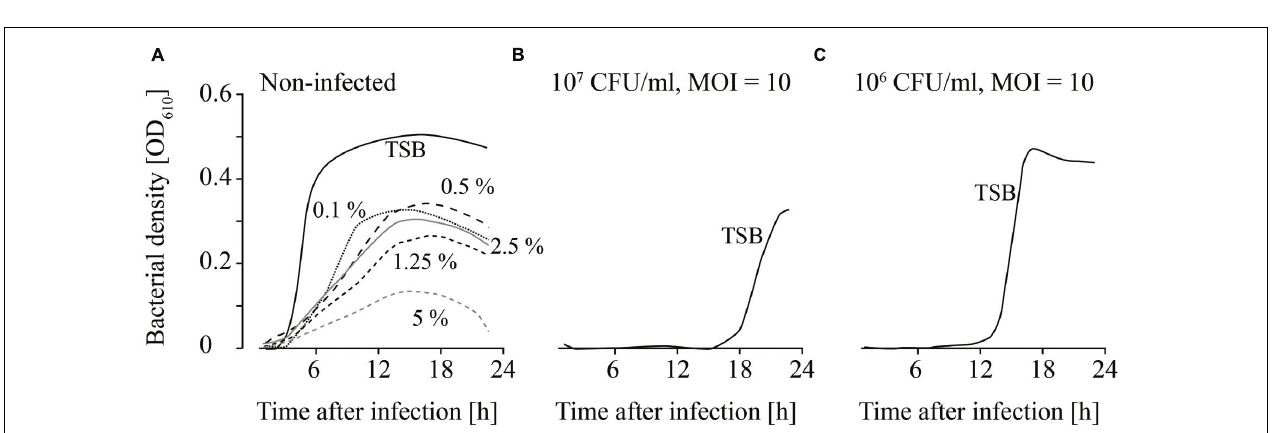
FIGURE 5 | Growth of uninfected (A) and infected (B,C; MOI = 10) L. monocytogenes in TSB adjusted to different pH values. The bacteria concentrations at the beginning of the infections were 10 7 CFU/ml (A) and (B) and 10 6 CFU/ml (C) . All pH values (4–11) were tested. For the sake of clarity only the curves of growing bacteria were demonstrated while the others on base line level were not depicted. Moreover, one of four independent experiments is representatively shown.